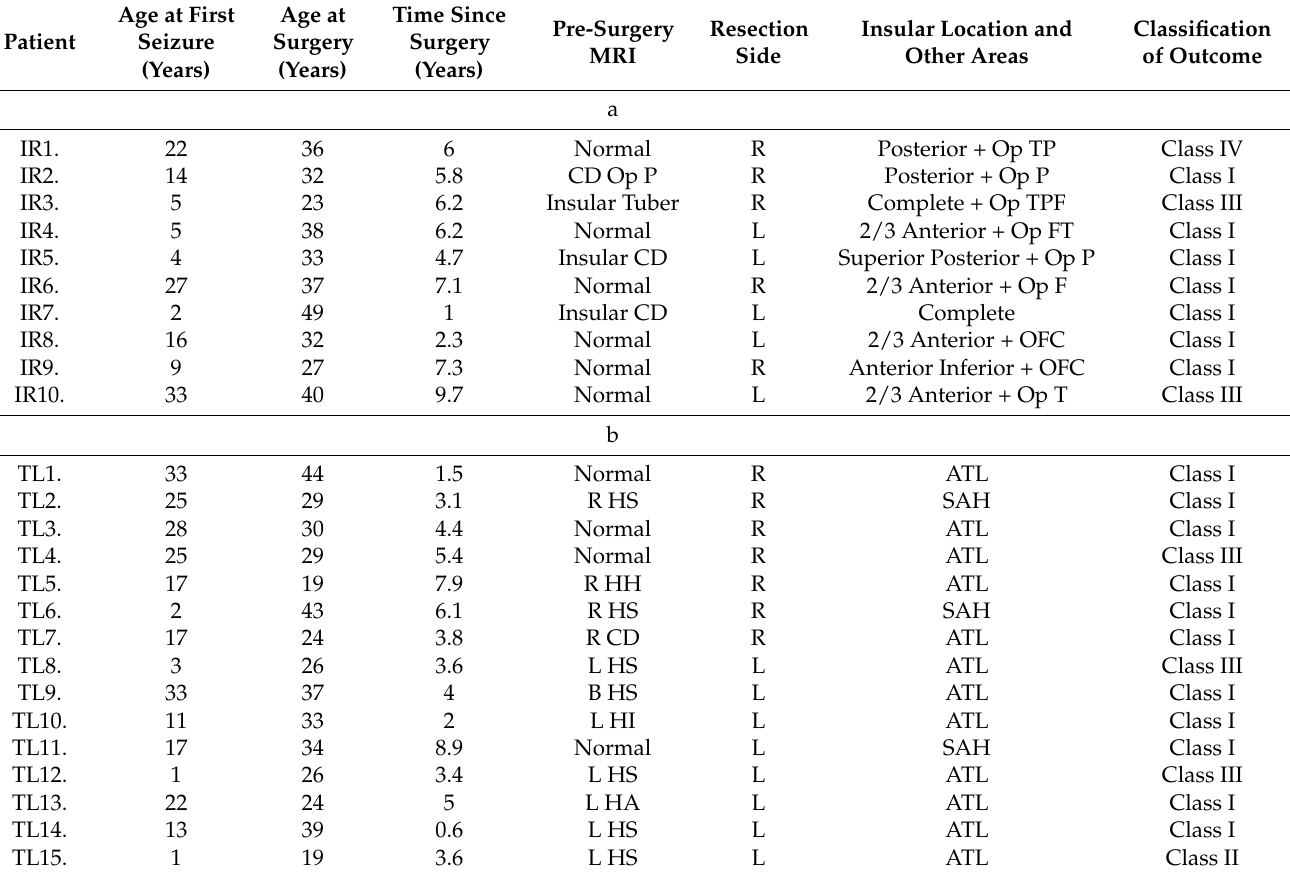
Classification of outcome based on [39]. Abbreviations: CD, cortical dysplasia; Op, operculum; F, frontal; P, parietal; T, temporal; OFC, orbitofrontal cortex; R, right; L, left; ATL, anterior temporal lobectomy; B, bilateral; CD, cortical dysplasia; HA, hippocampal atrophy; HS, hippocampal sclerosis; HH, hippocampal hypertrophy; HI, hippocampal T2/FLAIR intense signal; SAH, selective amygdalo- hippocampectomy; R, right; L,